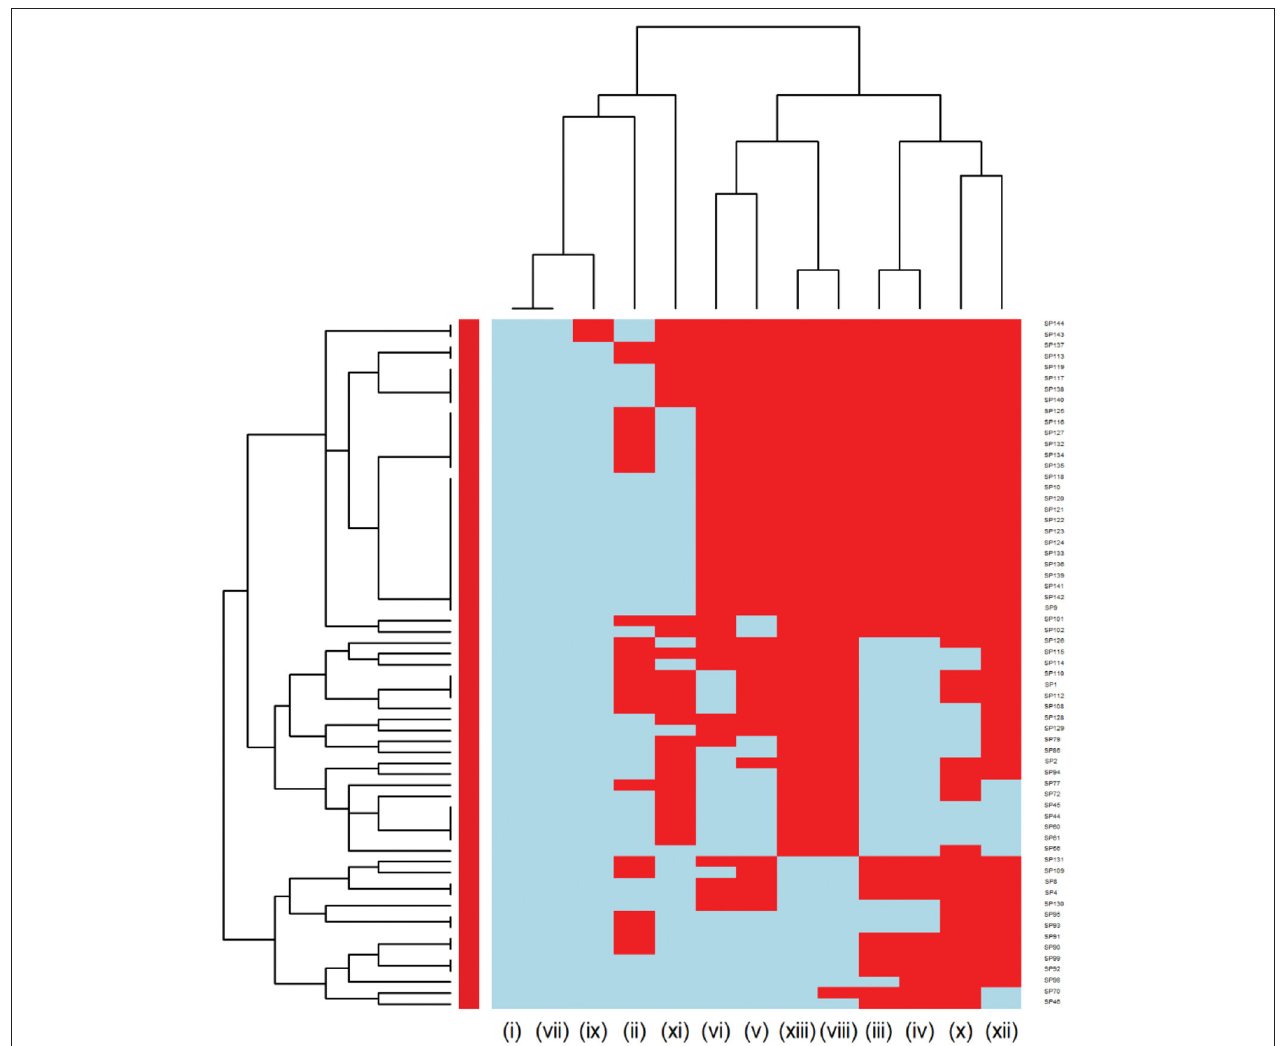
FIGURE 3 | Hierarchical clustering dendrogram of multi drug resistance patterns in Staphylococcus pseudintermedius isolated from canine urine samples a,b,c . a (i) Ansamycins; (ii) Aminoglycosides/Aminocyclitols; (iii) β -Lactam Combination Agents; (iv) Cephalosporins; (v) Folate Pathway Antagonists; (vi) Fluoroquinolones; (vii) Glycopeptides; (viii) Lincosamides; (ix) Nitrofurans; (x) Penicillins; (xi) Phenicols; (xii) Tetracyclines; (xiii) Macrolides. b Heatmap generated by hierarchical clustering of the antimicrobial resistance determinants (columns) of bacterial isolates (rows). c Red color, resistant; light blue color,